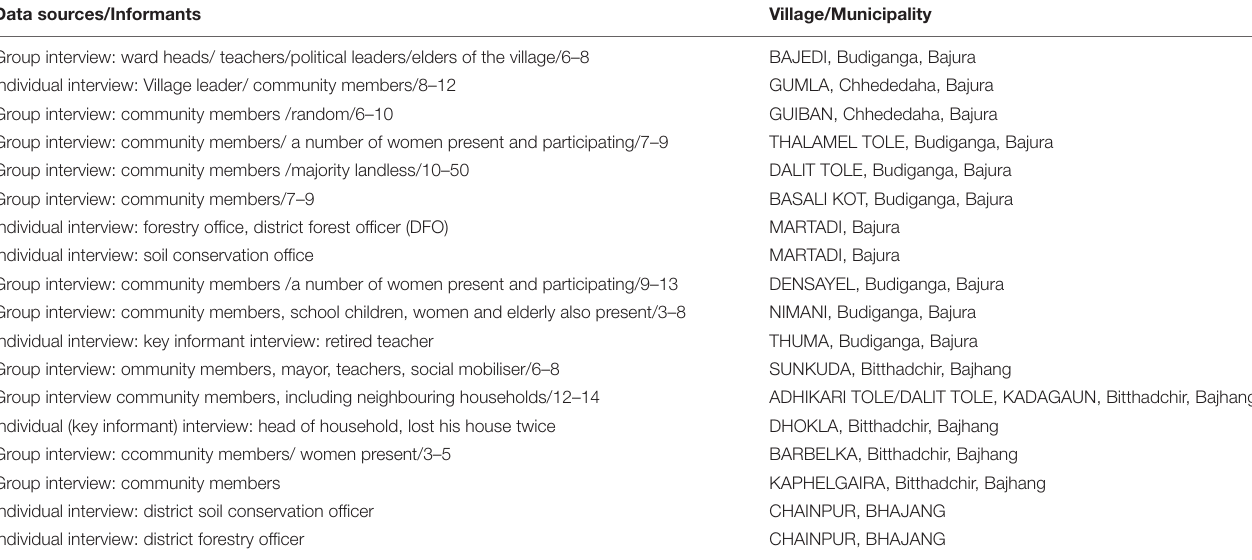
TABLE 2 | Respondents: individual and group